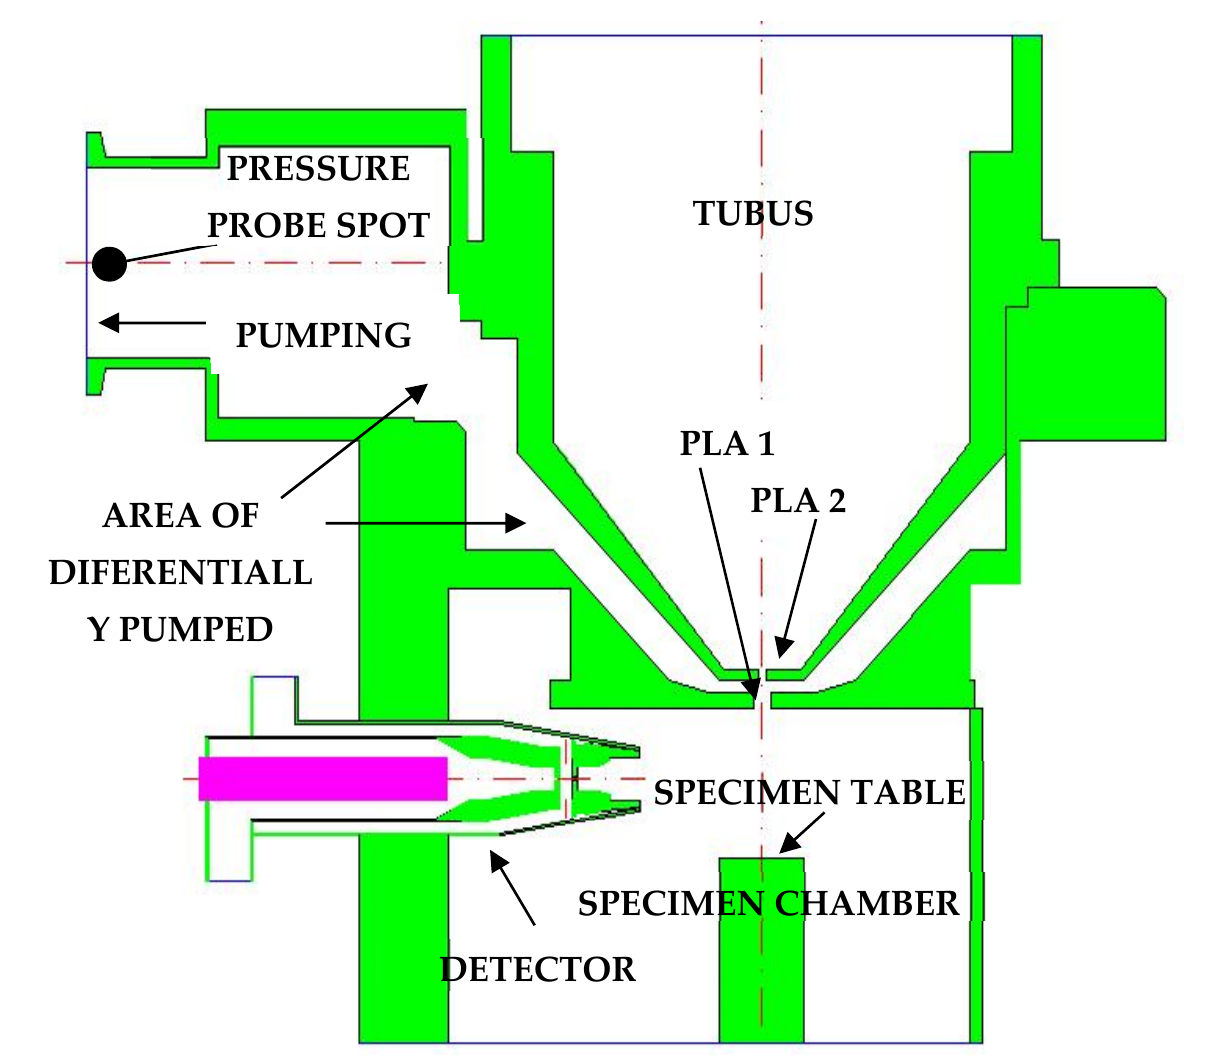
Figure 2. Electron microscope AQUASEM II sectional view with Boundary Condition.